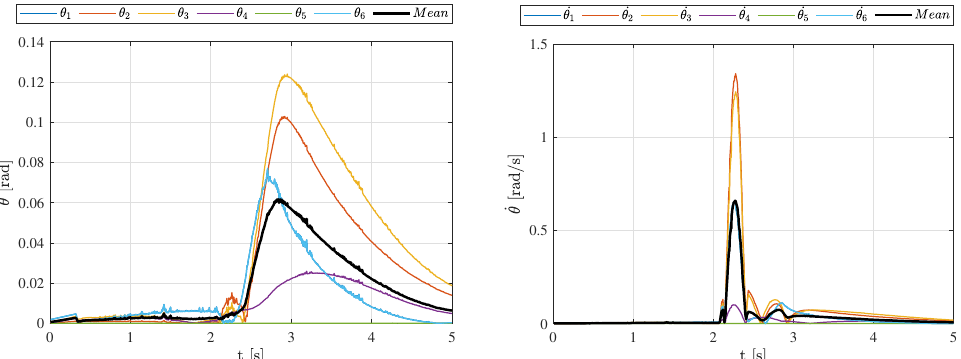
Figure 13. Test case 2, Mode III. The error between simulation and real system. Joint rotations ( left ) and joint speeds ( right